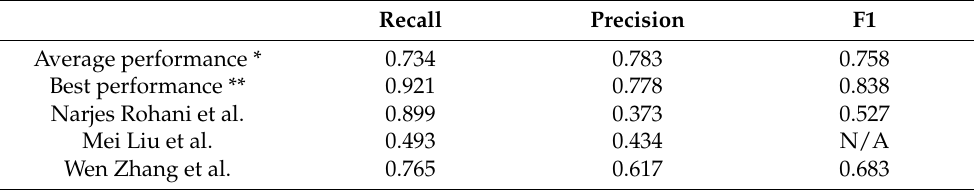
Table 5. HAINI performance compared with previous studies using chemical similarity. Recall Precision F1 Average performance *